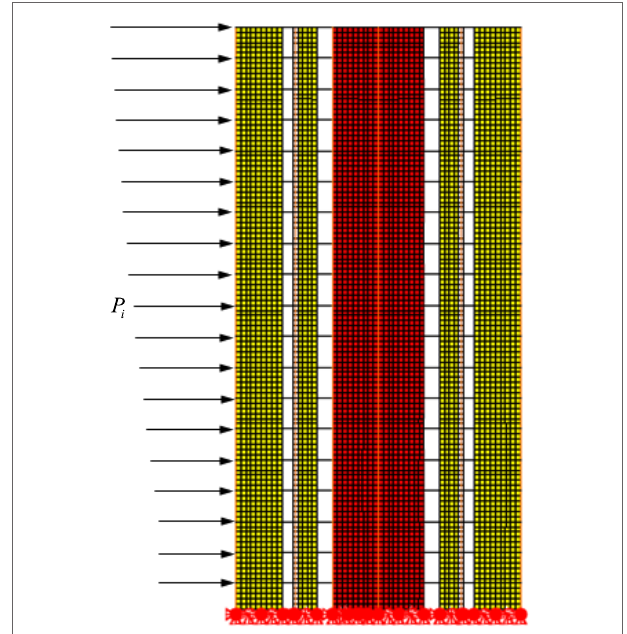
FigUre 5 | Wind load applied on the finite element model.